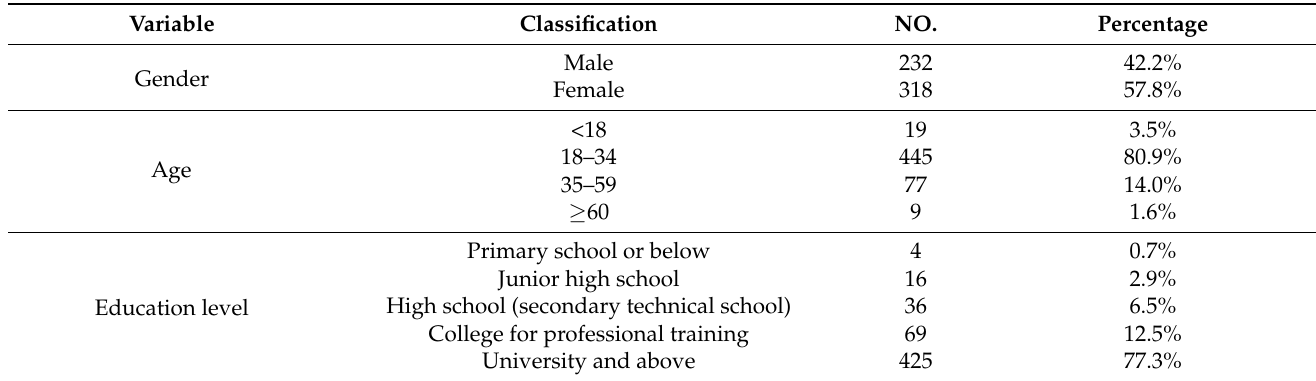
Table 3. Demographic characteristics of the